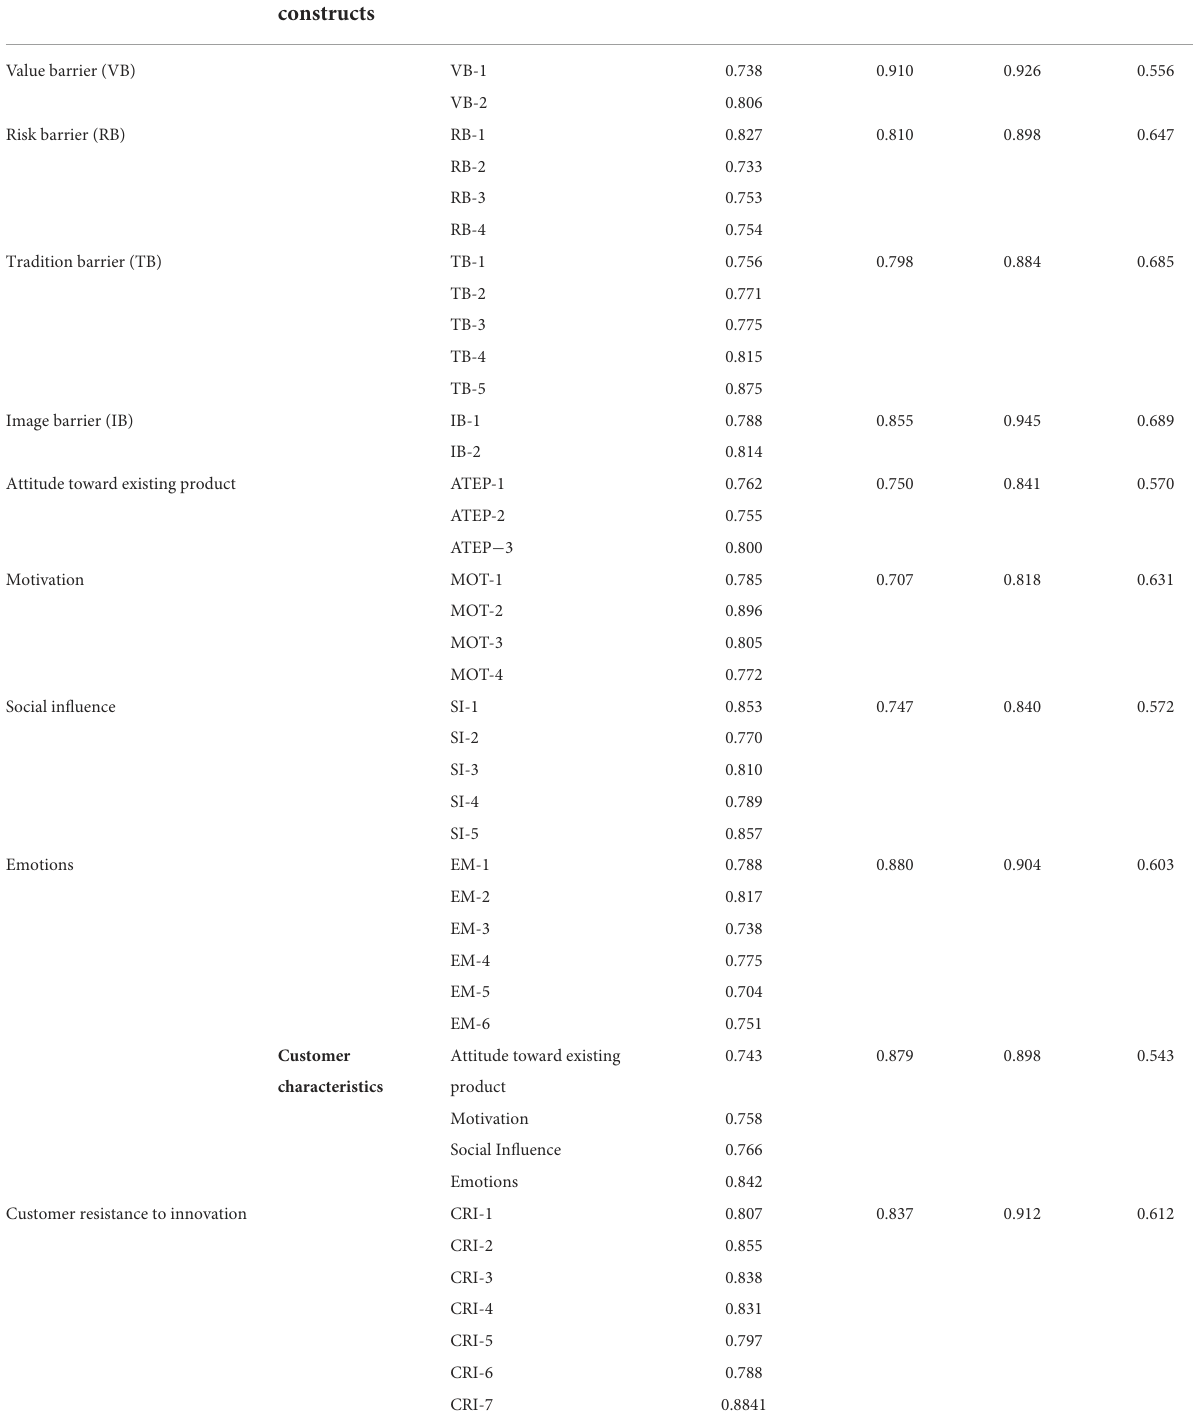
TABLE 2 Measurement model, loading, construct reliability, and convergent